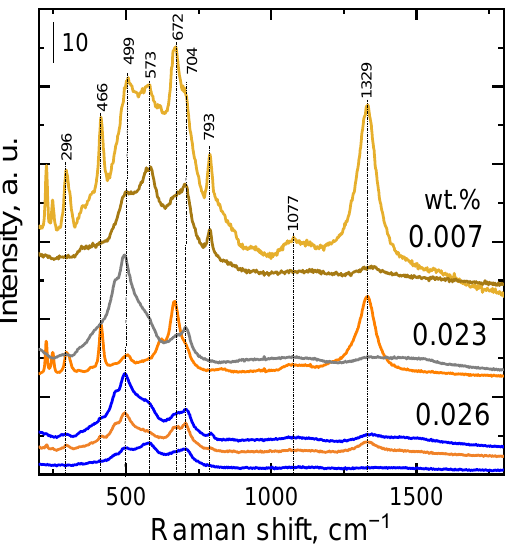
Figure 5. Raman spectra ( λ = 532 nm) of NiO deposited in various amounts on the stainless steel meshes (taken at two or three different points).